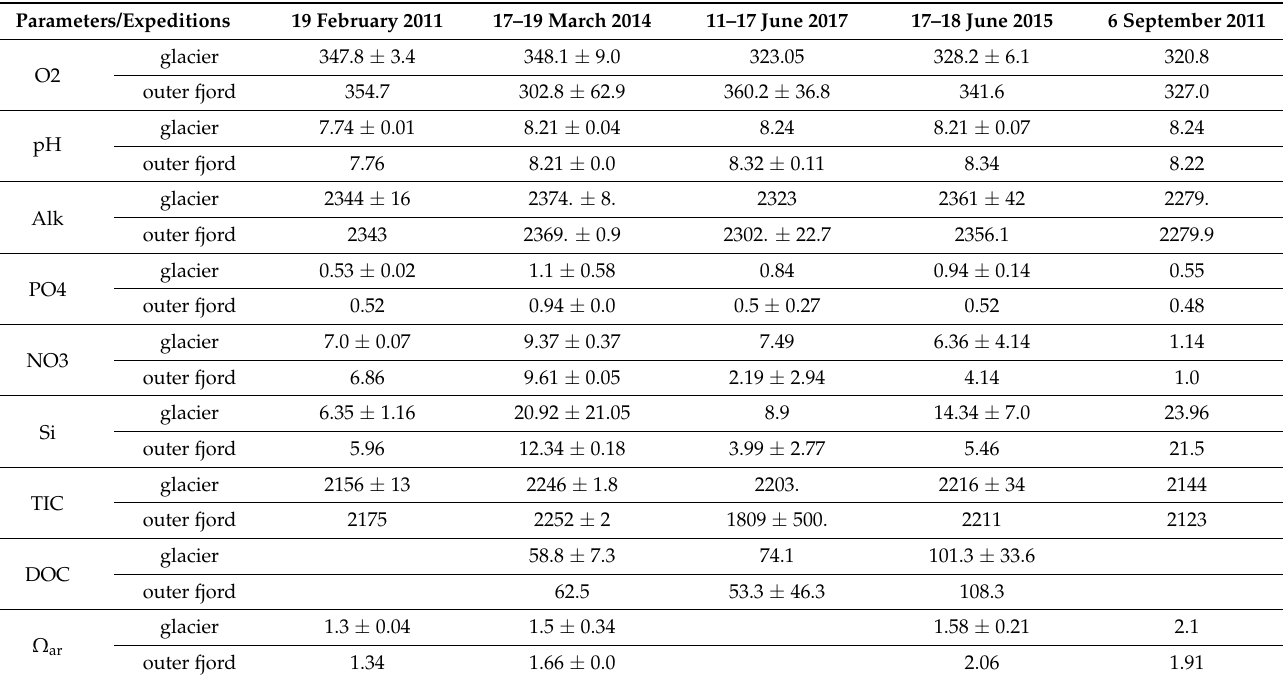
Table A7. Seasonal and interannual changes of nutrients in the bottom layer in the near glacier region and the outer